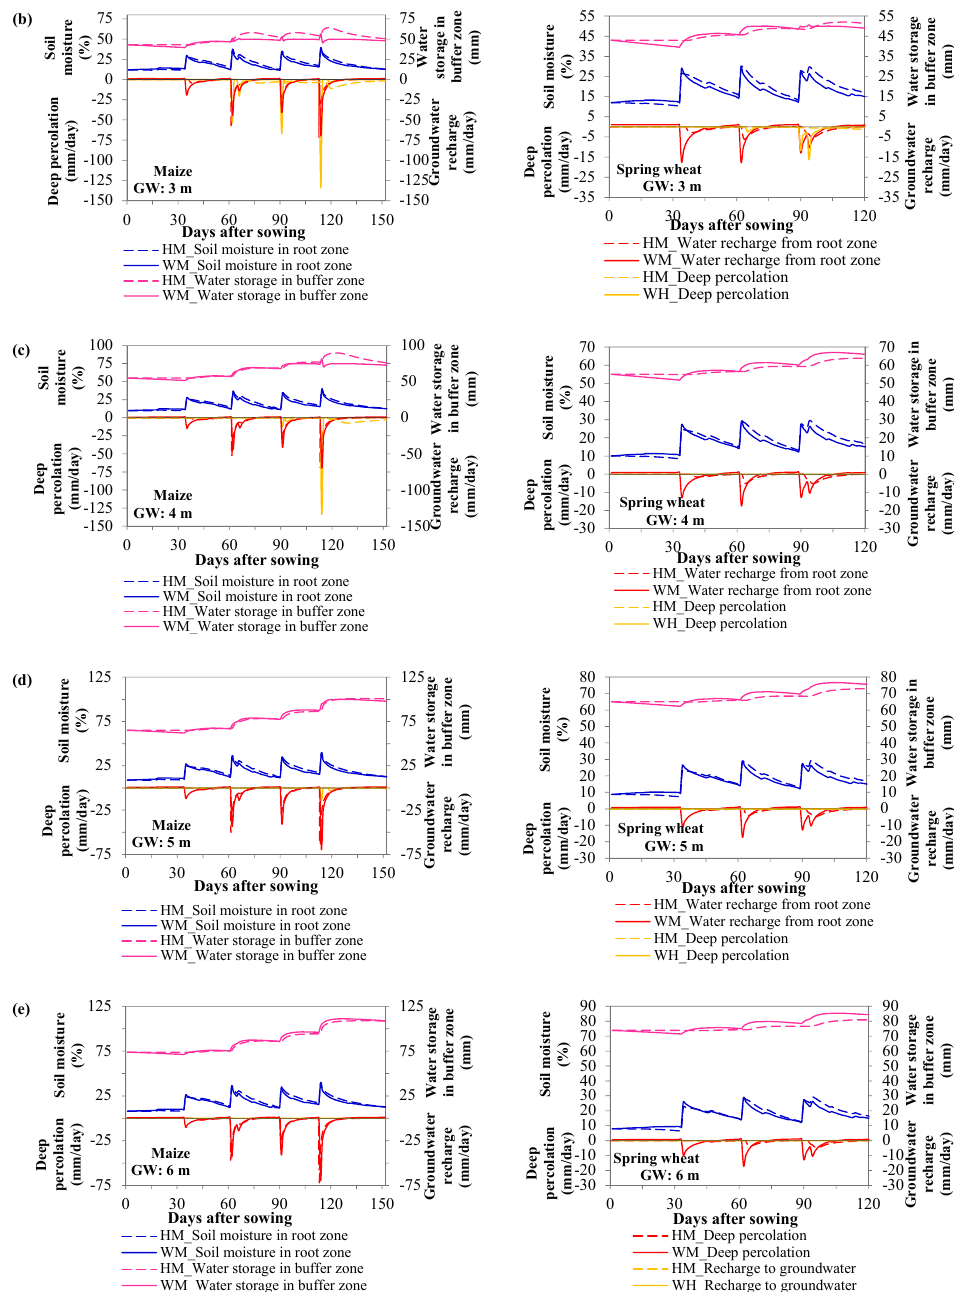
Figure 4. Simulation results of soil moisture, water storage in buffer zone, deep percolation and groundwater recharge for summer maize and spring wheat under the conditions of groundwater depths at 2 m ( a ), 3 m ( b ), 4 m ( c ), 5 m ( d ) and 6 m ( e ) (For deep percolation and groundwater recharge, negative values mean downward. HM means the results simulated by HYDRUS-1D, WM means the results calculated by water balance model, and GW means groundwater depth). Soil moisture in the root zone was relatively low because of less precipitation at the beginning of the crop-growing period, before irrigation. During this period, soil moisture calculated by water balance model was larger than that simulated by HYDRUS-1D. It is possibly because the empirical